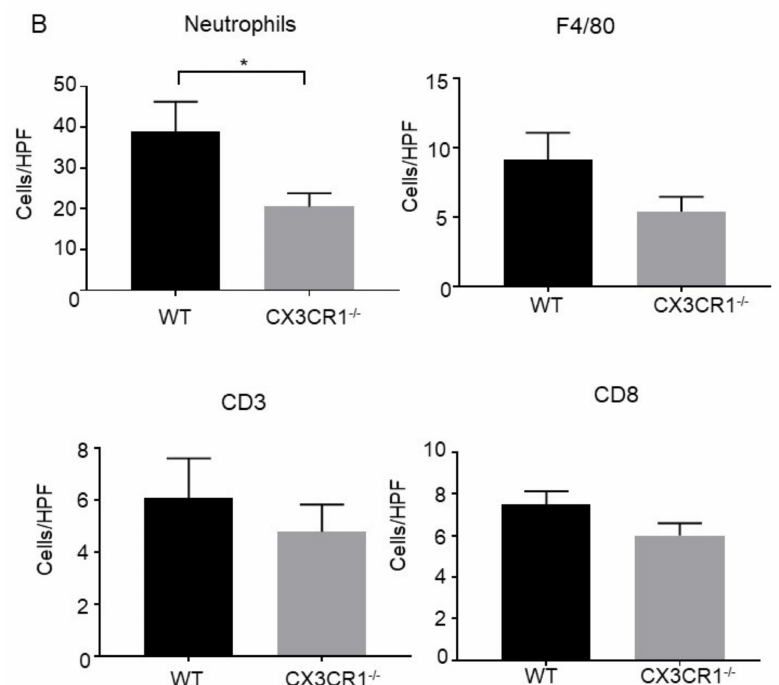
Figure 2. Dermal edema and neutrophil infiltration are decreased in CX3CR1 − / − mice. ( A ) Hematoxylin and eosin staining of skin samples at 48 h after elicitation. Representative pictures of wild-type (WT) mice and CX3CR1 − / − mice ( n = 5, respectively). Original magnification × 100; scale bar = 200 µ m. ( B ) The numbers of neutrophils, F4 / 80 + cells, CD3 + cells, and CD8 + cells per high power field in the skin samples of wild-type mice and CX3CR1 − / − mice at 48 h after elicitation. All values represent the mean ± SEM. n = 10. * p < 0.05 by Mann–Whitney